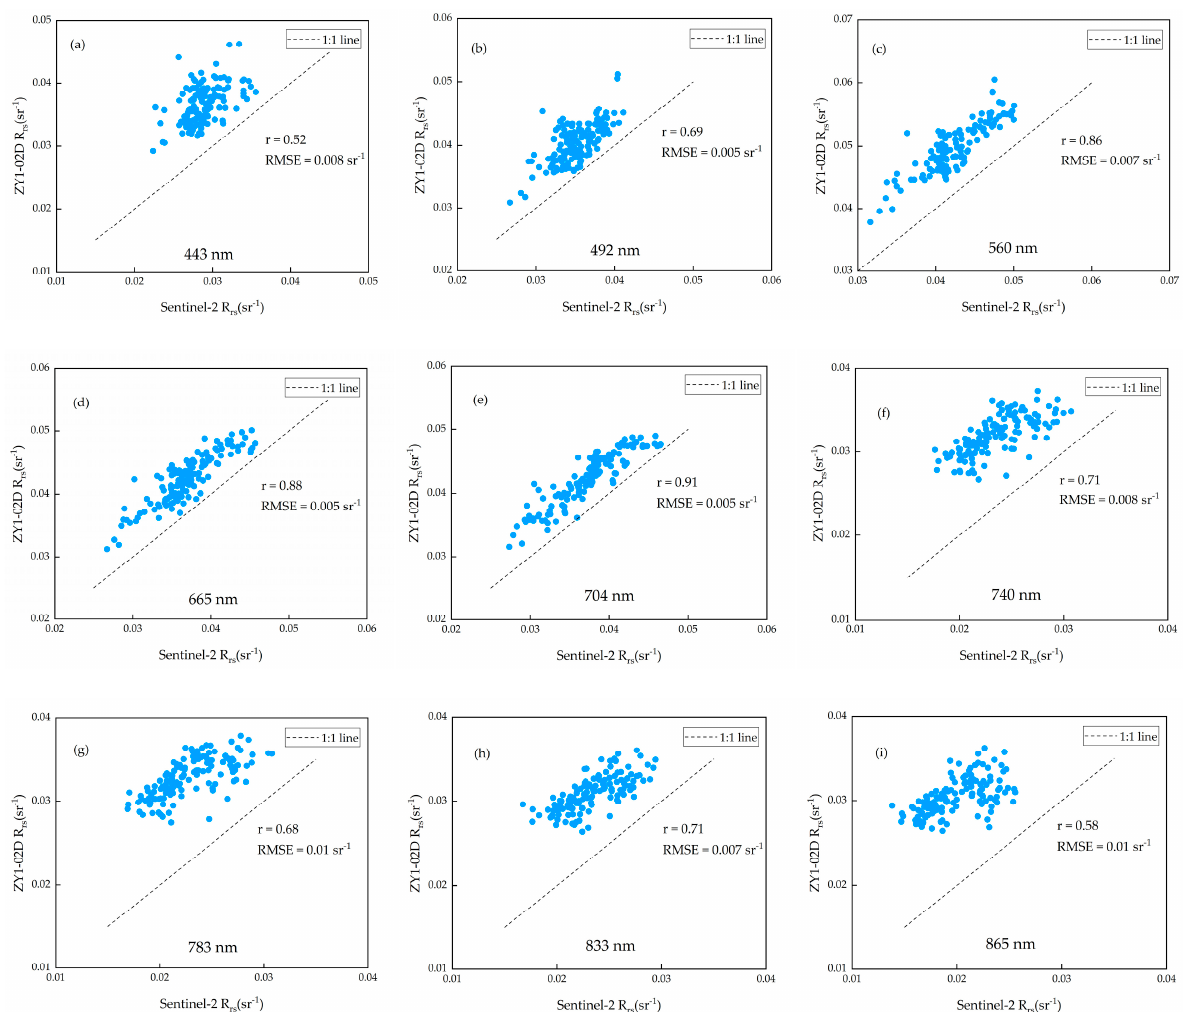
Figure 16. Comparison of R rs data between ZY1-02D and Sentinel-2 ( a – i ) represent the band-center wavelength of Sentinel-2,